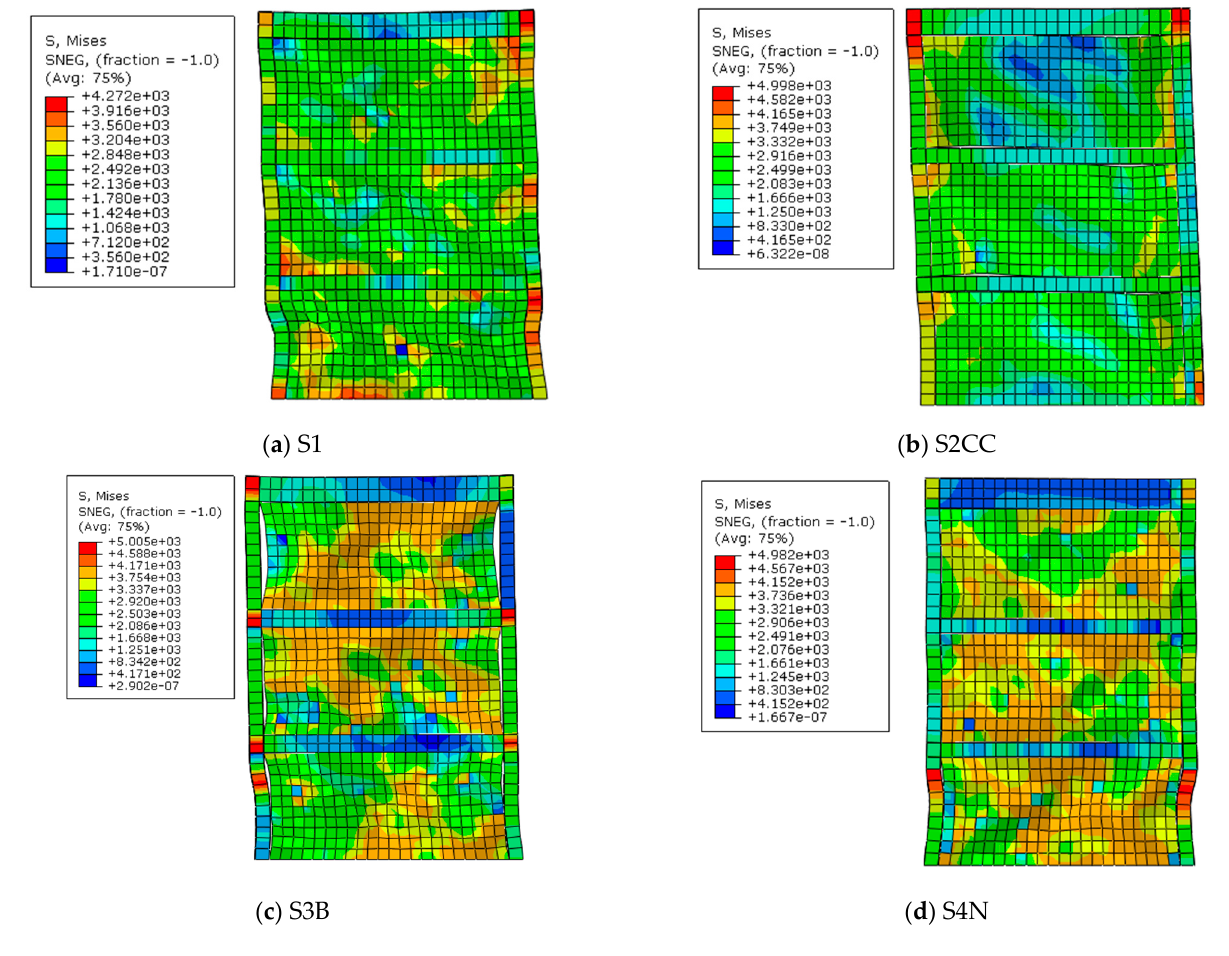
Figure 6. FE models under loading.